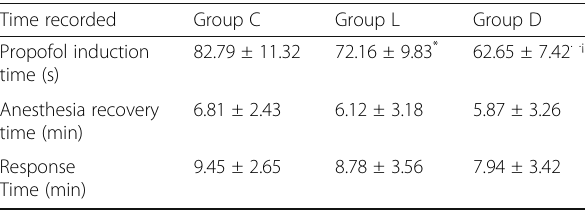
Table 5 Anesthesia induction and emergence times (mean ± standard deviation)